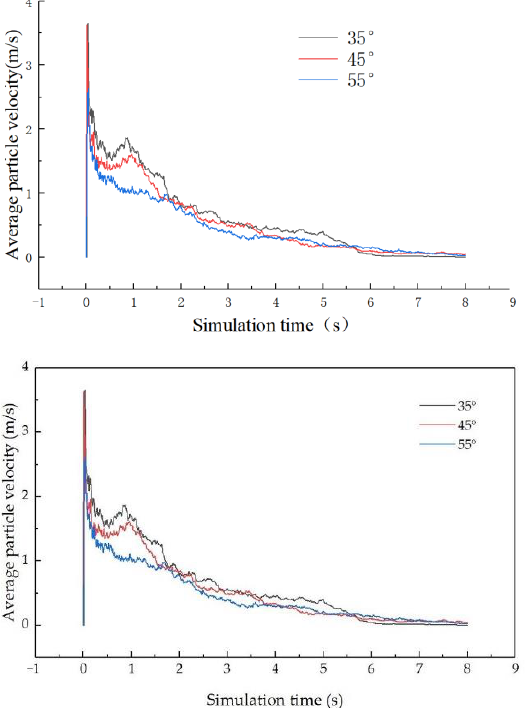
Figure 12. Variation curve of average particle velocity with time under different conveying inclination angles.